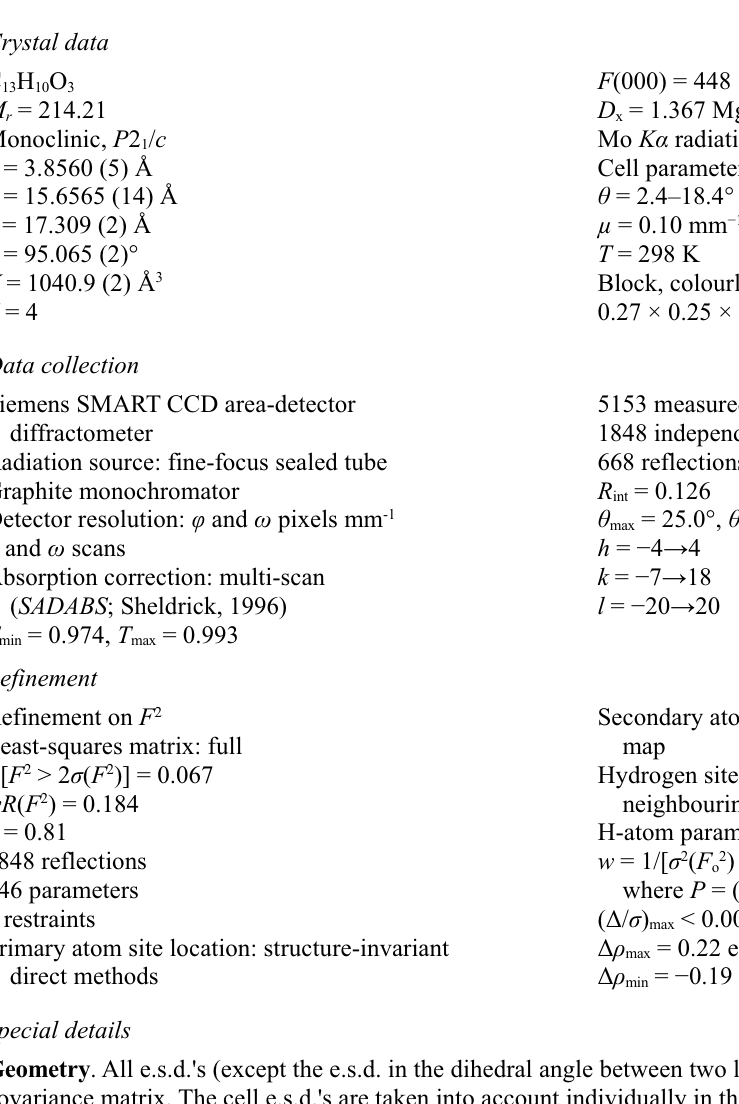
Figure 1 The molecular structure of (I) showing the atomic numbering and 40% probability displacement ellipsoids.